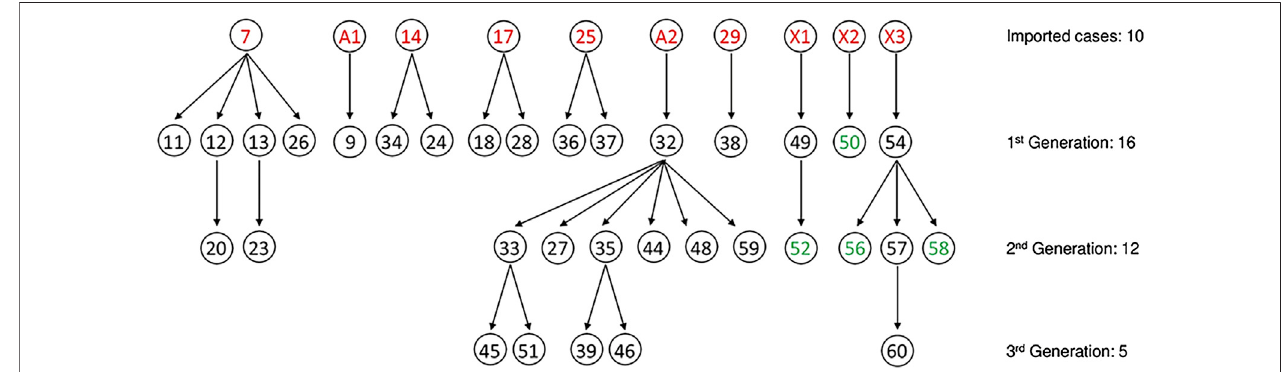
FIGURE 1 | SARS-CoV-2 transmission scenarios in Qingdao. Totally, 10 imported COVID cases (red number) cased 33 cases of human-to-human transmission (black or green number), among which 4 cases did not (green number) display typical symptoms of infection, such as fever. A1 was a suspected infected case from Wuhan. A2 was a con fi rmed infected case from Tianmen, Hubei. X1-3 was a suspected case in Qingdao.